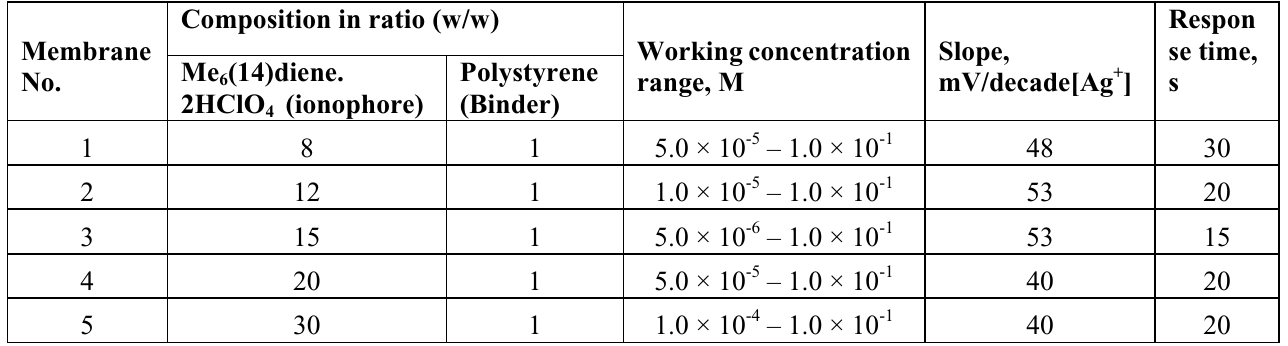
Table 2. Composition of polystyrene based membranes of Me and performance characteristics of Ag + - selective electrodes based on